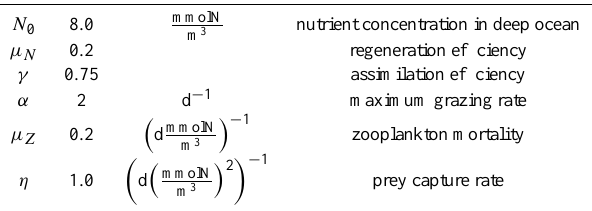
Table 2. Ecological parameters used in the biological model Eq. (3) (not characterizing the functional groups of phytoplankton).